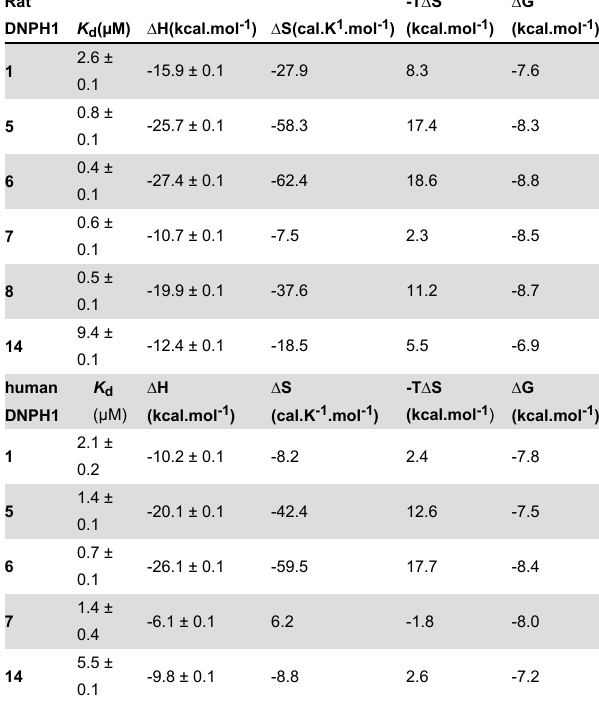
Figure 2. DNPH1 inhibition by cytokinin ribosides 5’- monophosphates and N 6 -substituted AMP.